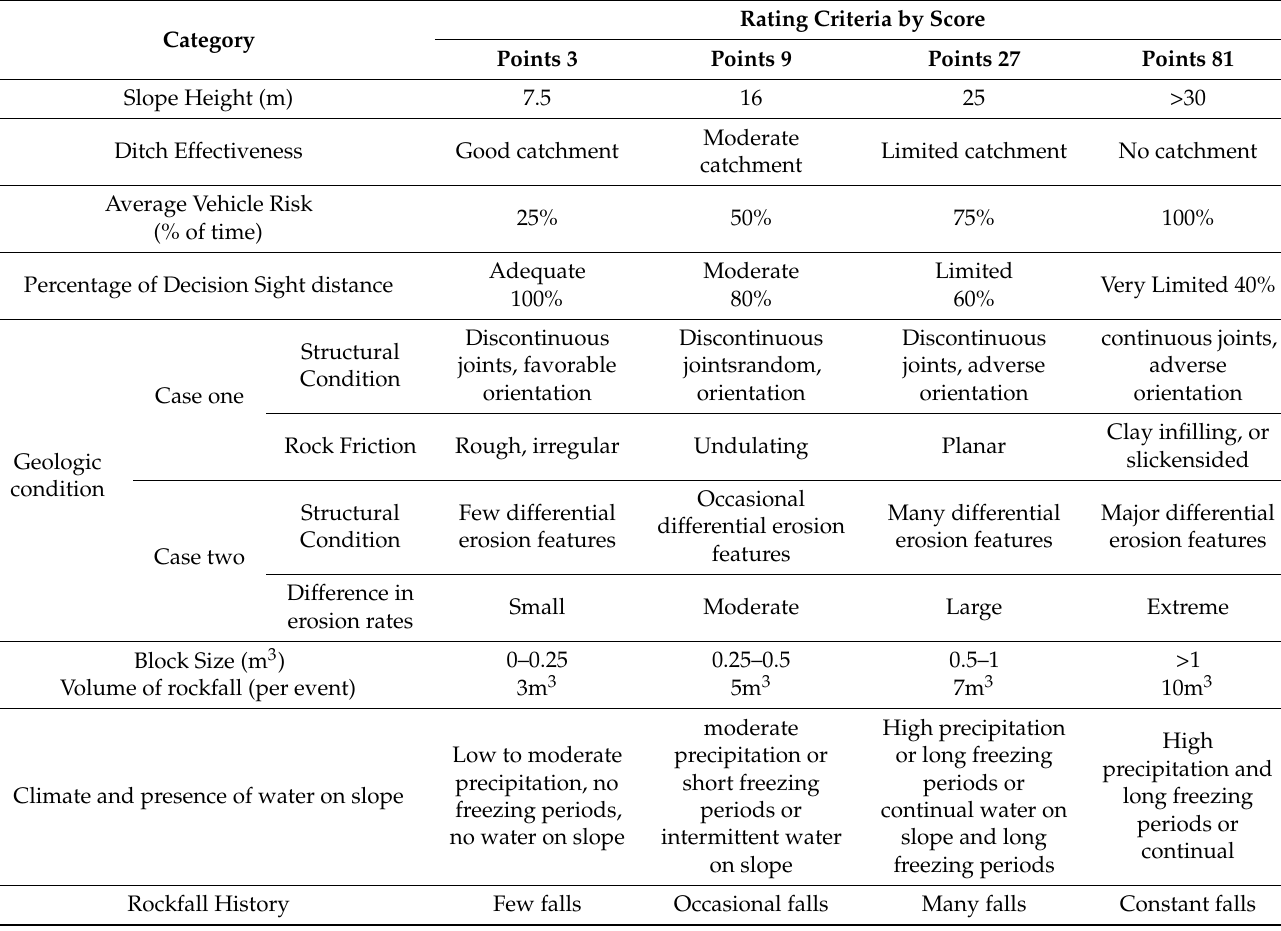
Table 1. A summary sheet of Rockfall Hazard Rating System after